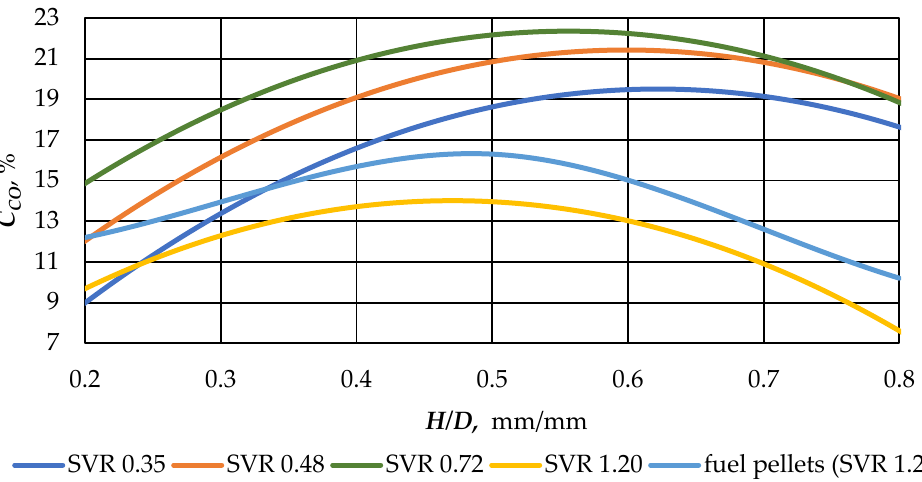
Figure 4. Graphic image of the dependence of CO concentration in the received gas on the ratio indicators of height to the reduction zone diameter ( H/D ) and on the ratio of the full side area ( S ) to the volume ( V ) of a fuel fraction ( SVR ).